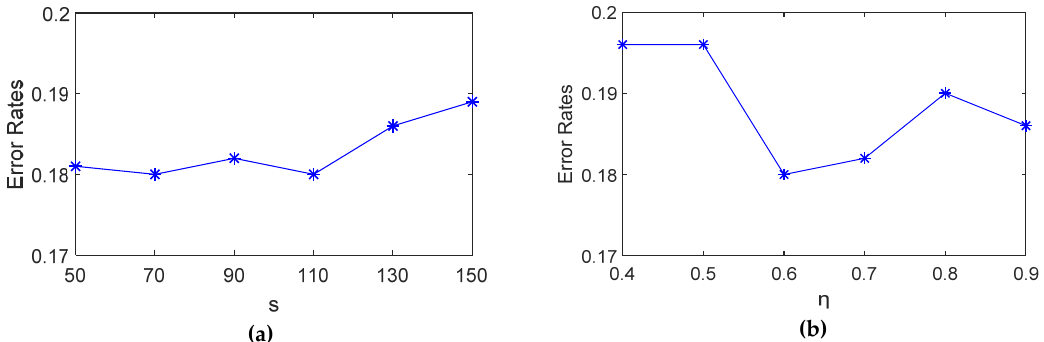
Figure 8. Results of adjustment of parameters: ( a ) Error rates when s is adjusted; ( b ) Error rates when η is adjusted.